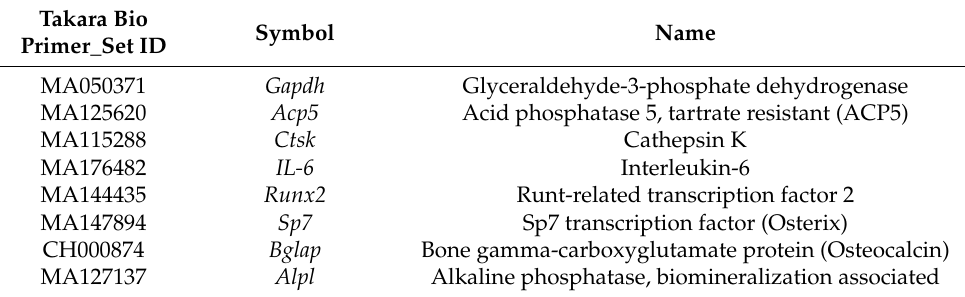
Table 2. List of target genes and primers for real-time